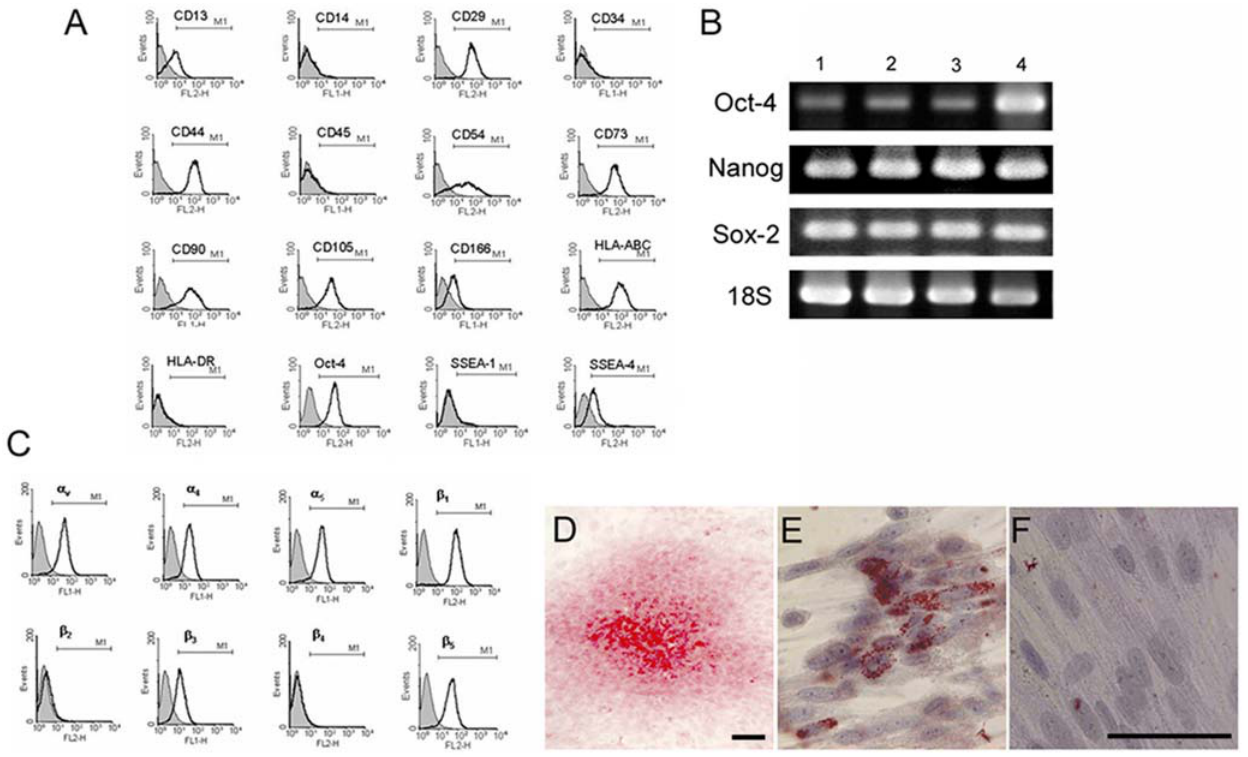
Figure 1. Characterization of human placental multipotent mesenchymal stromal cells (hPMSCs). (A) Flow cytometry analysis of cell- marker expression by hPMSCs. The cells express CD13, CD29, CD44, CD54, CD73, CD90, CD105, CD166, HLA-ABC, Oct-4, and SSEA-4, but are negative for HLA-DR, CD34, CD45, and SSEA-1. The shaded area shows the profile of the cells stained by a control antibody of matching isotype. Ten thousand cells were counted from each sample. (B) Analysis of stem cell markers on hPMSCs by RT-PCR analysis. Three different strains of hPMSCs are shown in lane 1 to 3. Lane 4 was RNA obtained from a human embryonic stem cell line (hES 6; ES Cell International, USA) and served as a positive control. PCR was performed for 35 cycles to demonstrate Oct-4 and Sox-2 transcripts, and 30 cycles for Nanog. (C) The expression of integrin subunits on hPMSCs determined by flow cytometry. The data shown are representative of 3 different experiments. (D) Osteogenic differentiation of hPMCs resulted in positive staining for Alizarin Red S, indicating the presence of calcium salt deposition associated with the matrix. (E) Adipocyte differentiation resulted in cytoplasmic lipid droplets that were Oil Red O–positive. (F) Undifferentiated hPMSCs used as a control for Oil Red O staining. The cells were counterstained with Mayer’s hematoxylin (E, F). Scale bar: 100 m m.